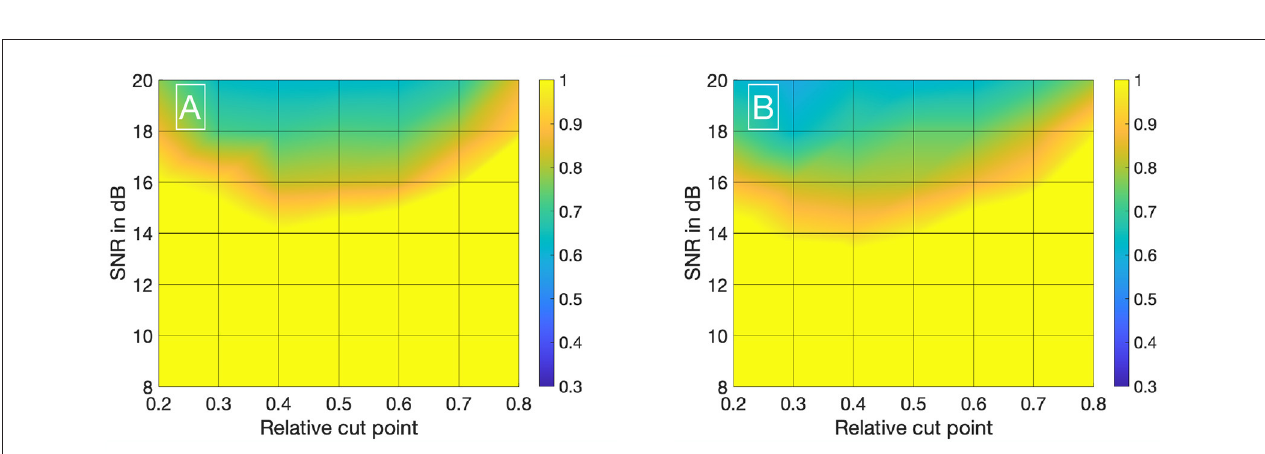
FIGURE 10 | (A) Mean ε frames using the raw data sets ( f sampling applying the cut method 2. (B) Mean ε frames using the linearly interpolated data sets ( f sampling cross-correlation is computed after applying the cut method 2.